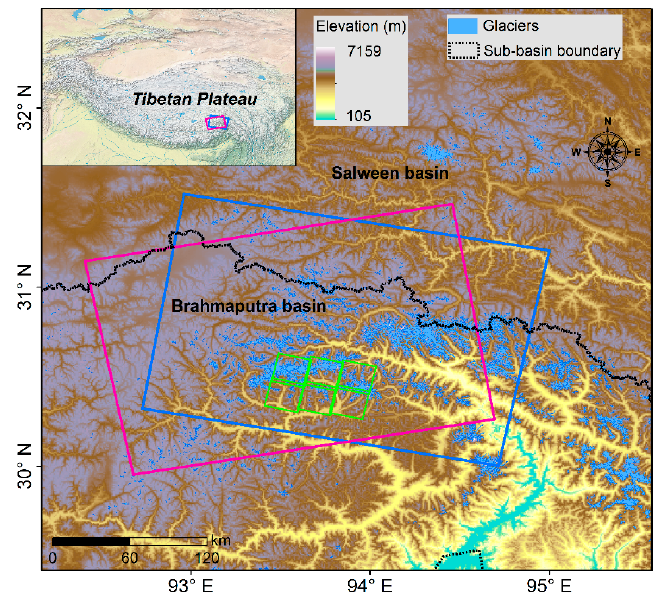
Figure 1. Geographic location of study area with the topographical characteristics and distribution of mountain glaciers in the two river basins. Pink and blue rectangles represent the frames of ascending and descending Sentinel-1 images, respectively. Green rectangles indicate the coverage of Gaofen-2 panchromatic multi-spectral (GF-2 PMS) images used for accuracy evaluation of the glacial lake mapping results.